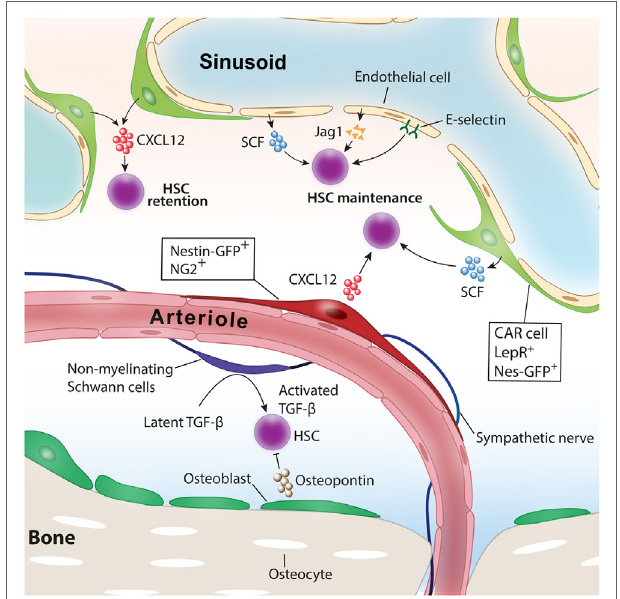
FigURe 1 | Niche cells for healthy hematopoietic stem cells (HSCs). Various cell types have been identified as niche cells for HSCs in steady-state bone marrow. Perivascular stromal cells such as NG2 + periarteriolar cells and LepR + perisinusoidal stromal cells differentially regulate HSCs. Nonmyelinating Schwann cells maintain HSC quiescence by activating transforming growth factor- β (TGF- β ). Adopted and modified from Ref.